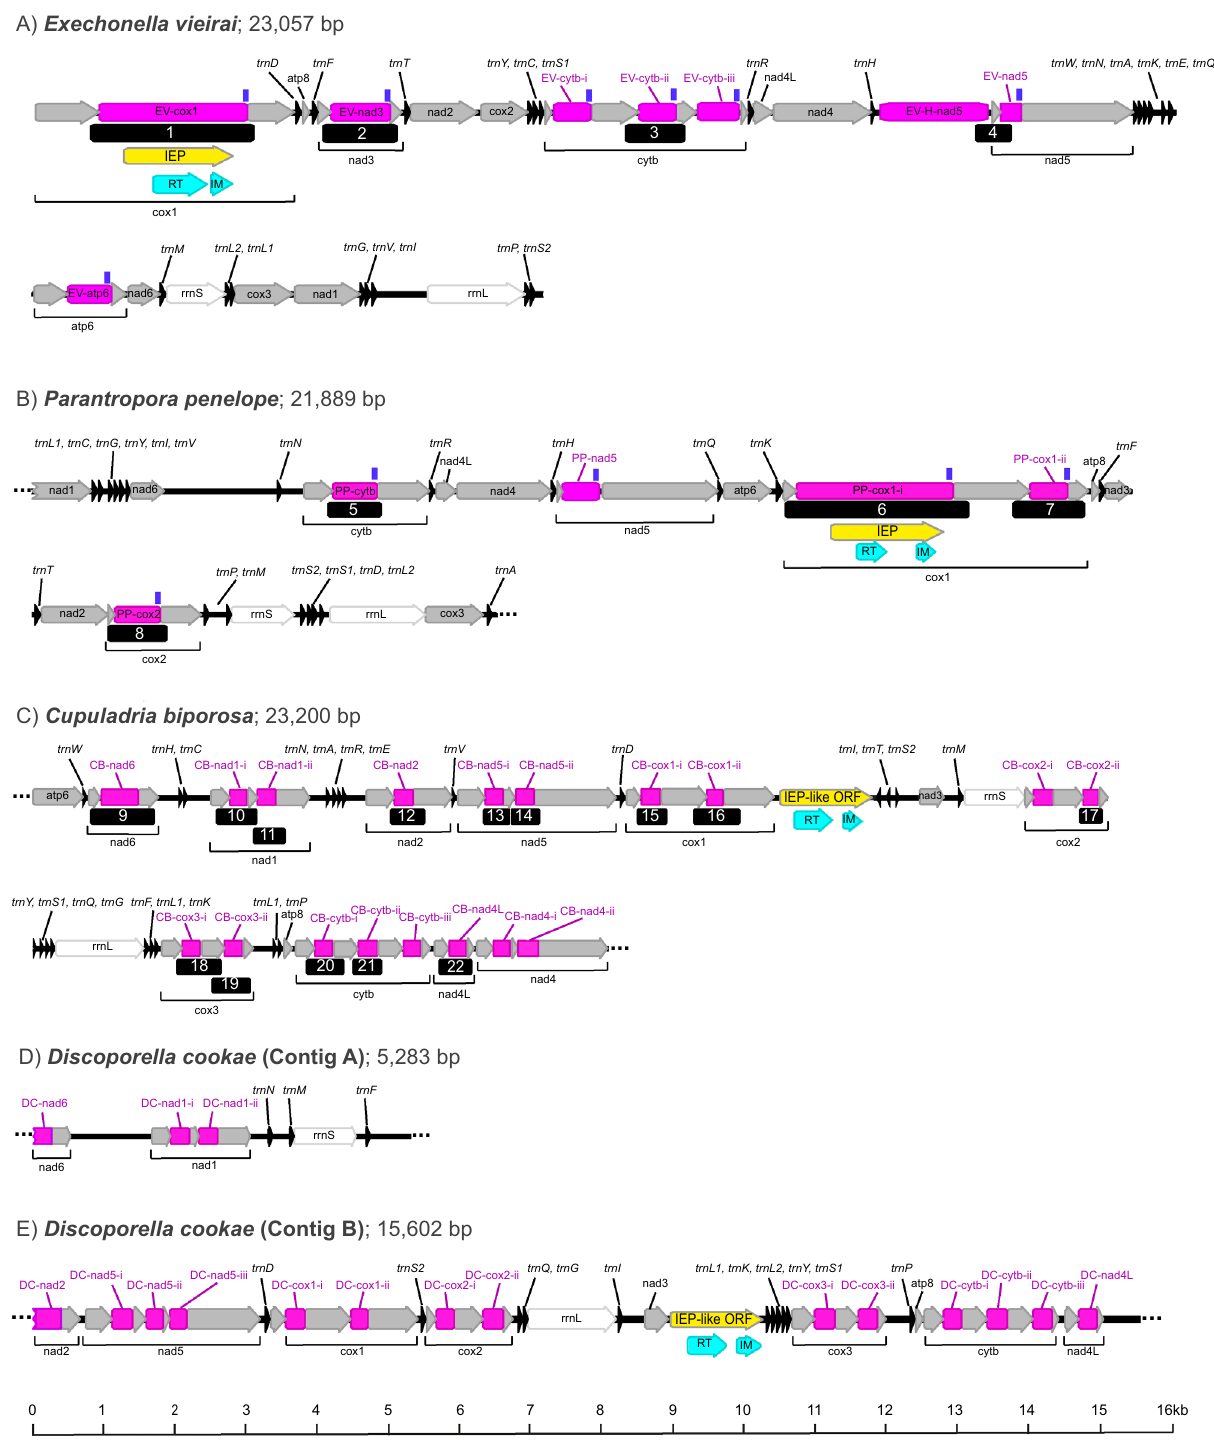
Figure 2. Mitogenome maps showing gene order and PCR product locations (black boxes 1–22). Linearised complete mitogenome of Exechonella vieirai ( A ). Partial mitogenome of Parantropora penelope ( B ). Non- circularised mitogenome of Cupuladria biporosa ( C ). Contig A of Discoporella cookae ( D ). Contig B of Discoporella cookae ( E ). Introns are labelled as pink boxes. Conserved Group II ribozyme domains V and VI, as found by Rfam, are indicated by vertical blue bars. Capital prefixes in intron labels represent genus/species initials. Whenever multiple introns were found per gene, introns were labelled with suffixes i-iii. Open reading frames (ORFs) of intron-encoded proteins (IEPs) are shown as yellow arrows. In the cases of C. biporosa and D. cookae , these ORFs are labelled as ‘IEP-like ORFs’ because they do not nest within introns. ORFs of reverse transcriptase (RT) and intron maturase (IM) are shown as turquoise